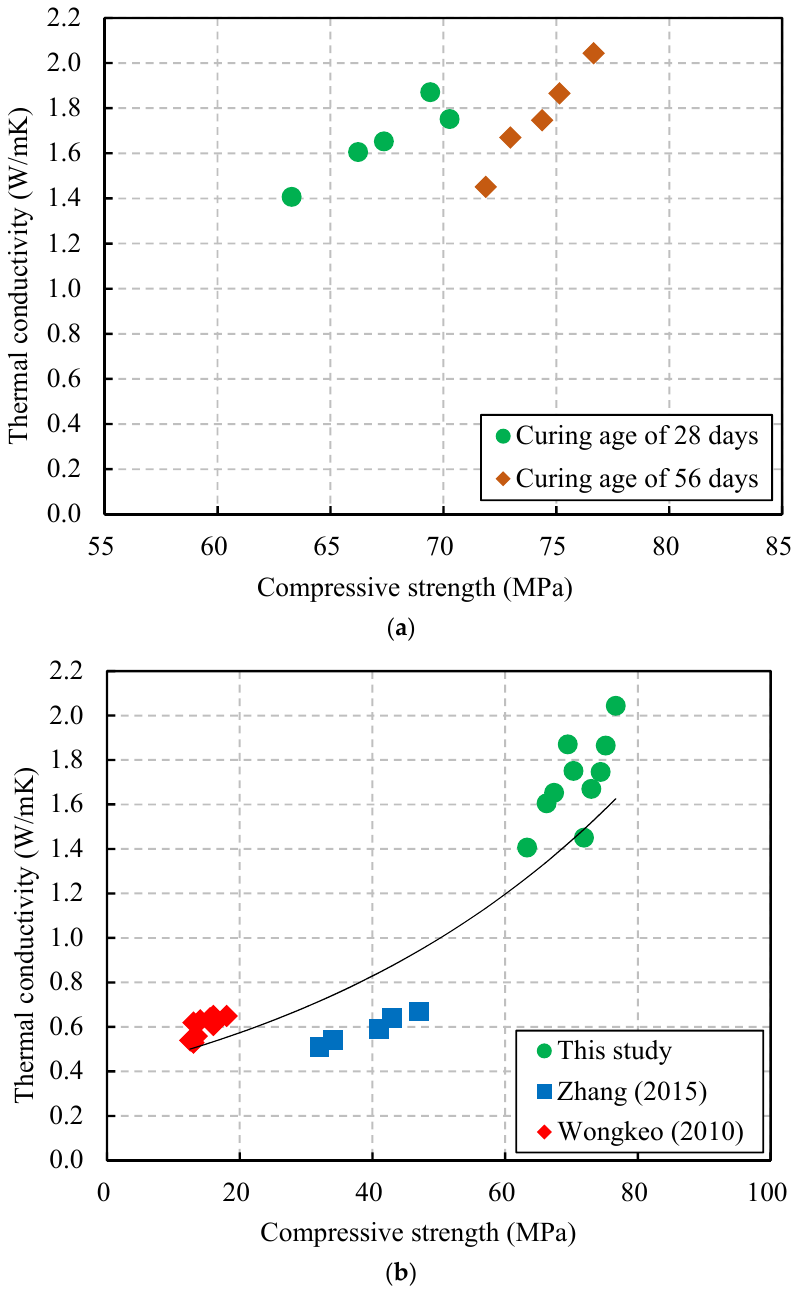
Figure 11. Relationship between the thermal conductivity and the compressive strength. ( a ) Test results in this study; ( b ) relationship based on the results in this study and previous studies.